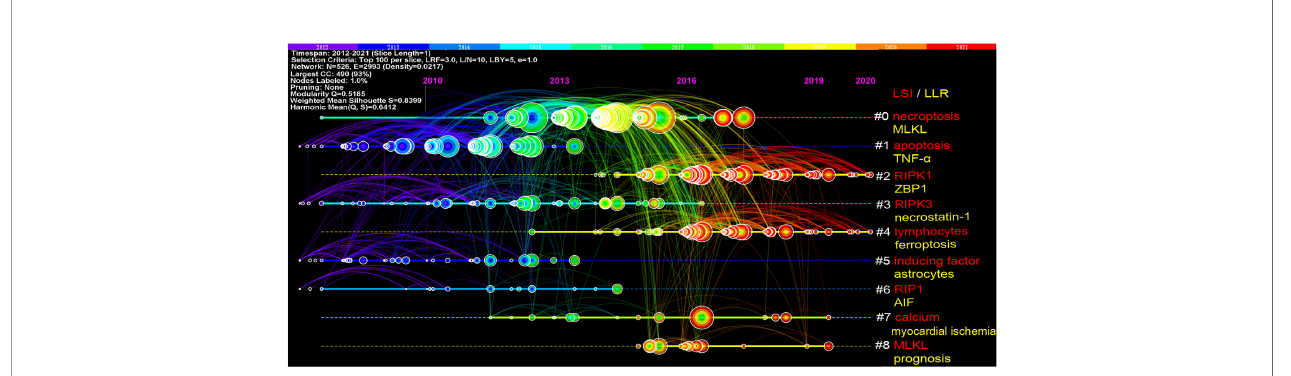
FIGURE 6 | Timeline view of co-cited references related to necroptosis. Each horizontal line represents a cluster; the smaller the number, the larger the cluster, and #0 is the largest cluster. The node size re fl ects the co-cited frequencies, and the links indicate the co-cited relationships; the color of node and line represent different years; nodes are at their fi rst co-cited year. Cluster labels were extracted from title by LSI (red) and LLR (yellow).